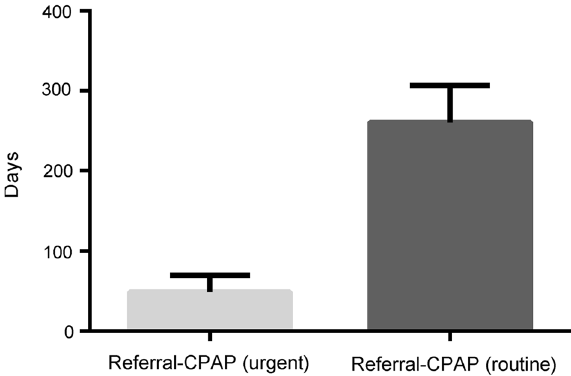
Fig. 4 Wait-times from referral to sleep assessment, MDM discussion and CPAP therapy in